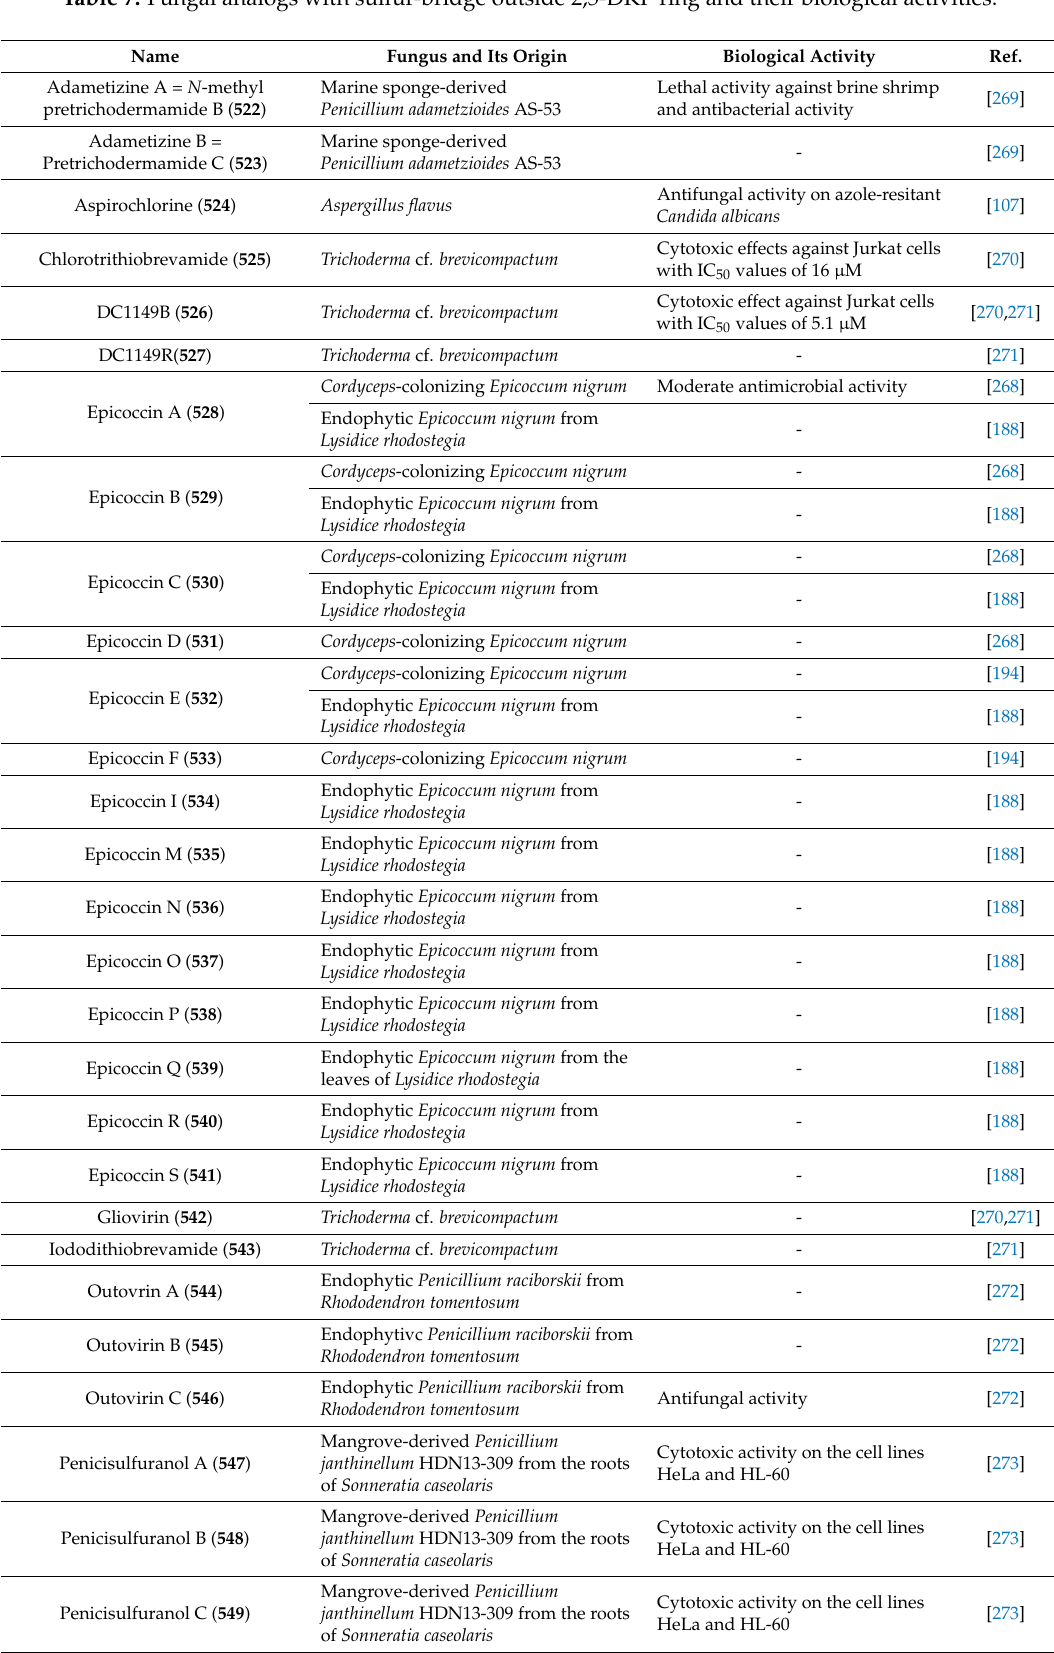
Table 7. Fungal analogs with sulfur-bridge outside 2,5-DKP ring and their biological